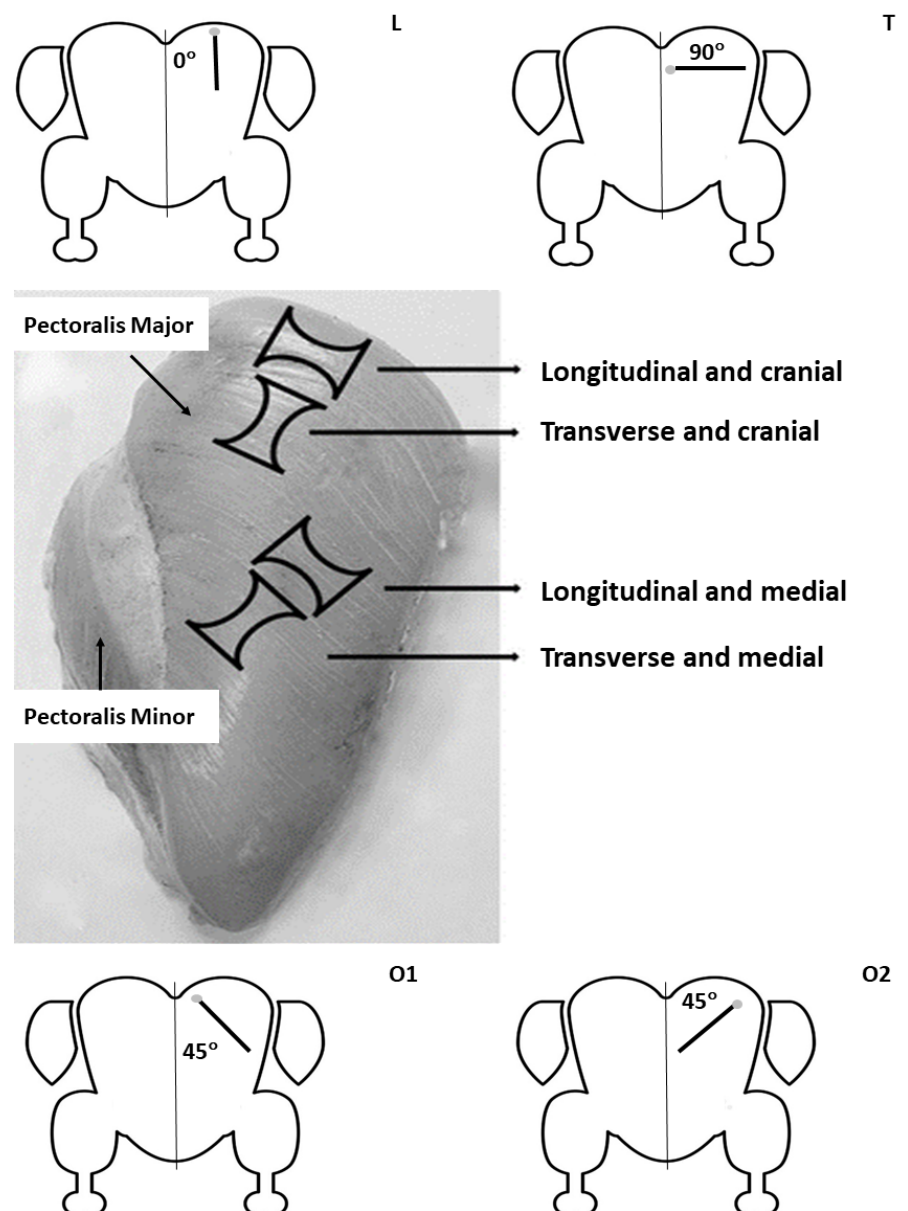
Figure 2. A figure illustrating the course of muscle fibers within the cranial and medial segments of the pectoralis major muscle of turkeys in relation to scanning planes or a position of the shaft of a transducer during ultrasonographic examinations (L-longitudinal, T-transverse, and O1 and O2-oblique). The angels are between the midline axis (sternum and keel bone) and the casing of a transducer placed above the left pectoralis major muscle. Light grey dots show direction of the transducer probe applied to the bird’s skin.